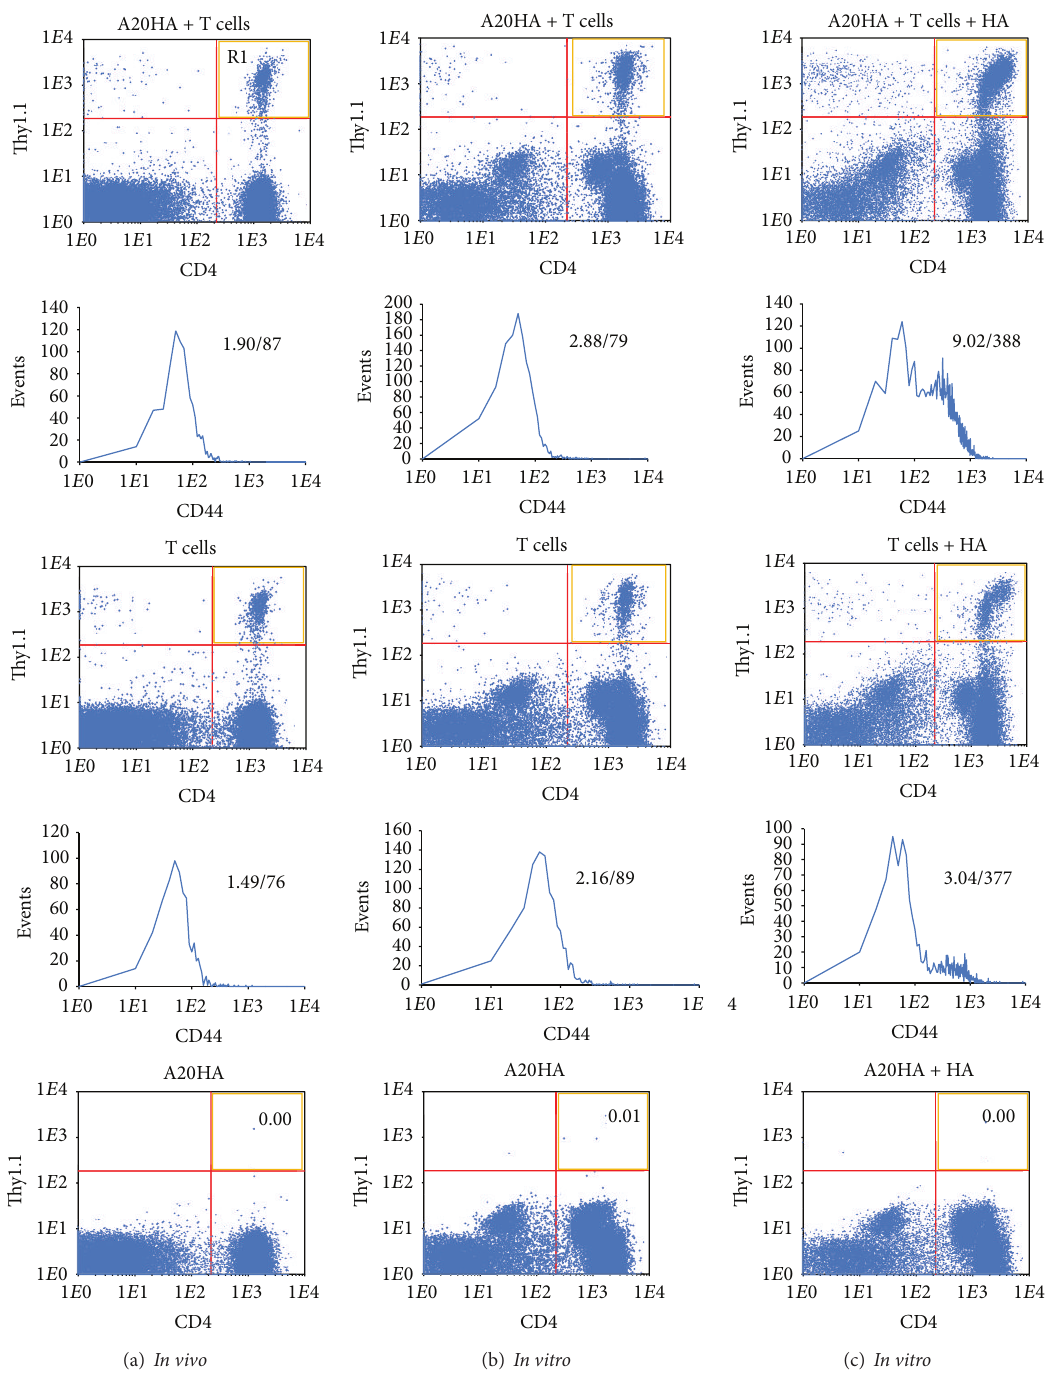
Figure 3: HA-specific CD4 + Thy1.1 + T cells from cervical lymph nodes of A20HA brain tumor-bearing mice show increased response to restimulation in vitro with MHC class II synthetic HA peptide. ((a), (b), (c)) Flow cytometry of CD4 + Thy1.1 + CD44 + T cells from cervical lymph nodes on day 2 after adoptive transfer. HA-specific CD4 + Thy1.1 + T cells were injected i.v. into A20HA brain tumor-bearing mice 5 days after i.c. tumor inoculation (A20HA + T cells; dot plots in the upper row) and a tumor-free control group (T cells; dot plots in the middle row). A20HA brain tumor-bearing mice in the absence of HA-specific CD4 + Thy1.1 + T cells represented a negative control (A20HA; dot plots in the lower row). Cervical lymph nodes were pooled and analyzed for CD4 + Thy1.1 + CD44 + T cells (a) before incubation ( in vivo column; right upper quadrants) and ((b), (c)) after 72 h incubation in vitro in triplicates (b) without ( in vitro column; right upper quadrants) and (c) with ( in vitro column; right upper quadrants) HA peptide. Histograms under the dot plots show the level of CD44 expression in the gated populations of CD4 + Thy-1.1 + T cells (shown in the right upper quadrants). Numbers above histograms indicate percent of gated CD4 + Thy-1.1 + T cells in the designed dot plots (left numbers) and intensity of CD44 expression by these cells (right numbers). One representative experiment of equivalent two is